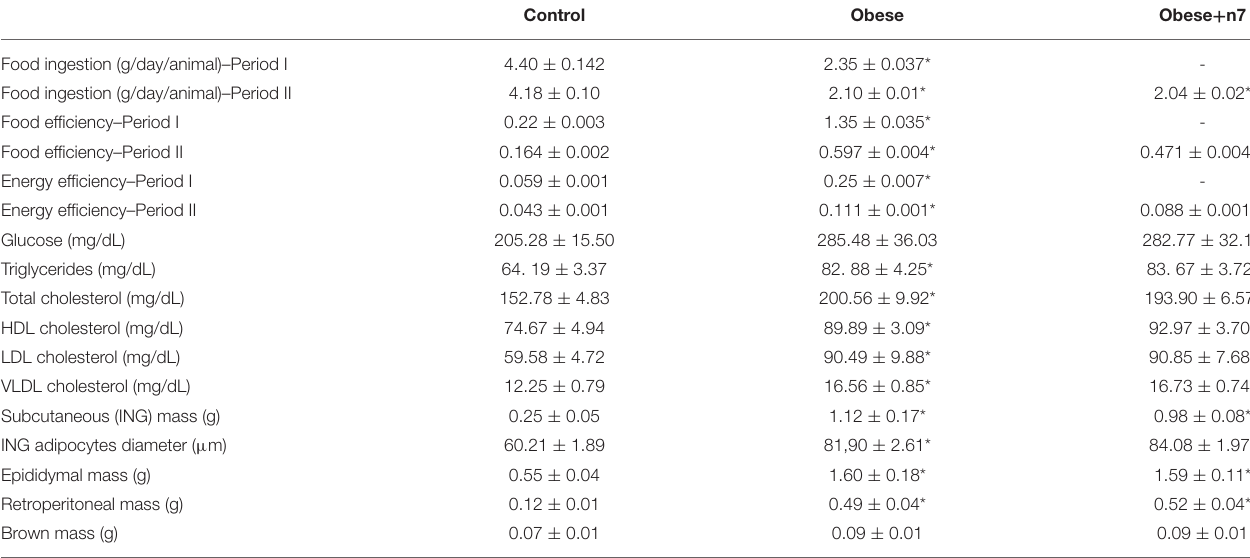
TABLE 2 | Dietary intake, food and energy efficiency, fasting plasma glucose, triglycerides, total and fractions cholesterol, and adipose tissues mass. Control Obese Obese +